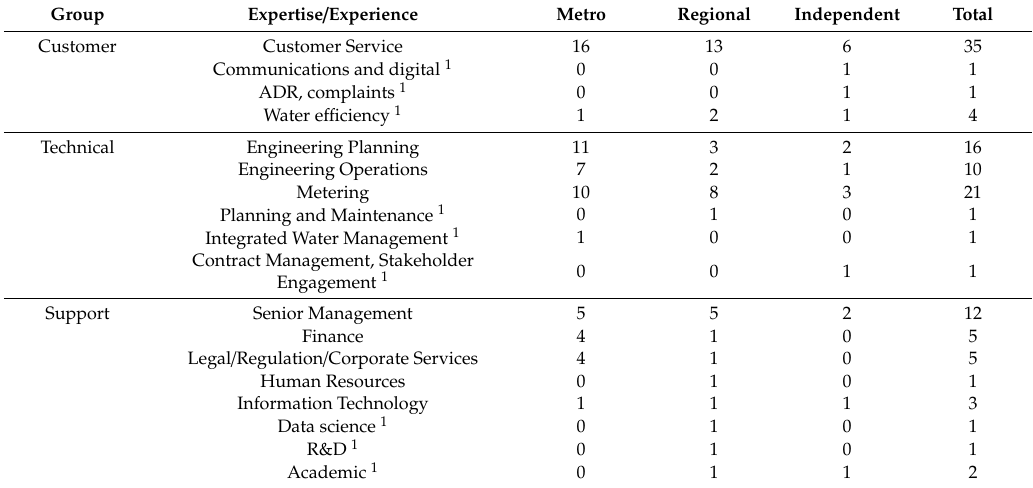
Table 2. Respondents’ areas of experience / expertise by organisation type (multiple selected questions). Group